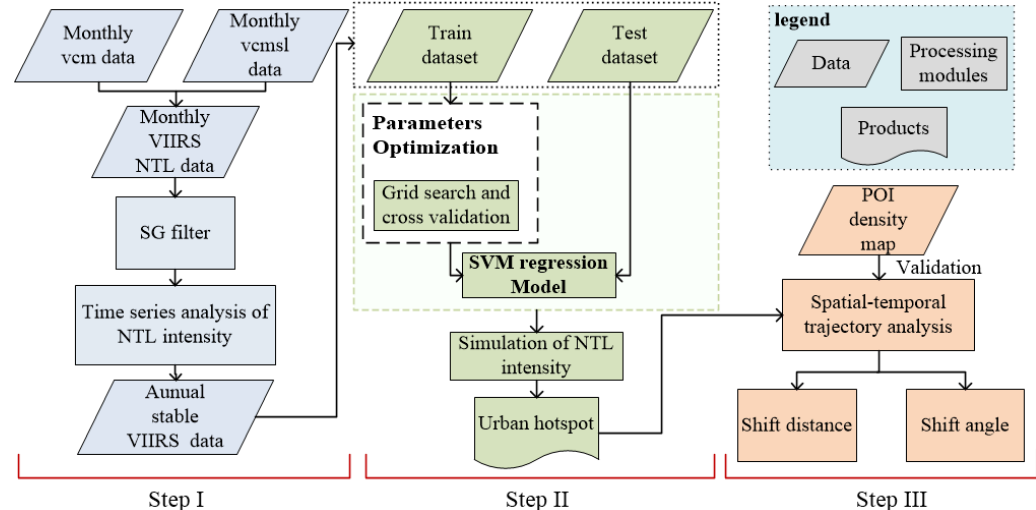
Figure 3. Flowchart of our proposed application framework.